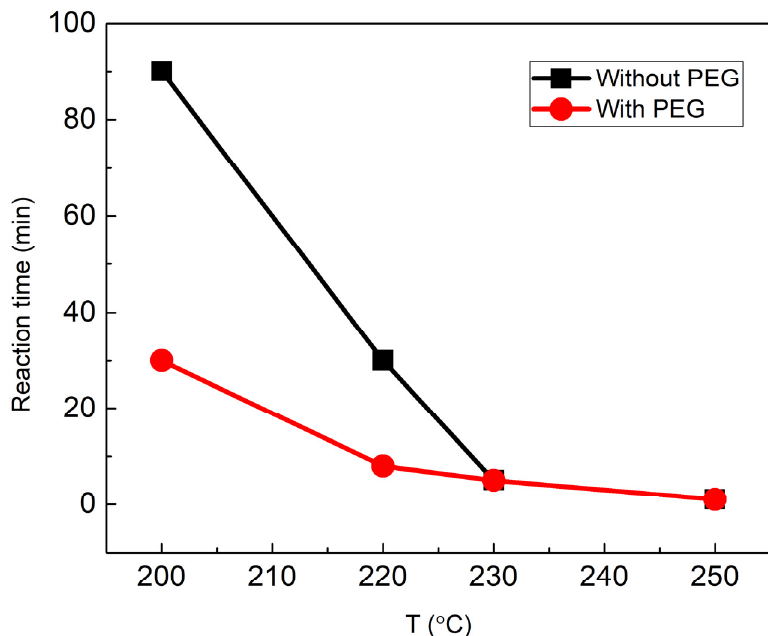
Figure 2. Reaction time dependence on the temperature maintained by the microwave reactor. A difference is noticed in the reaction times at low temperatures when PEG is added to the initial reaction mixture.